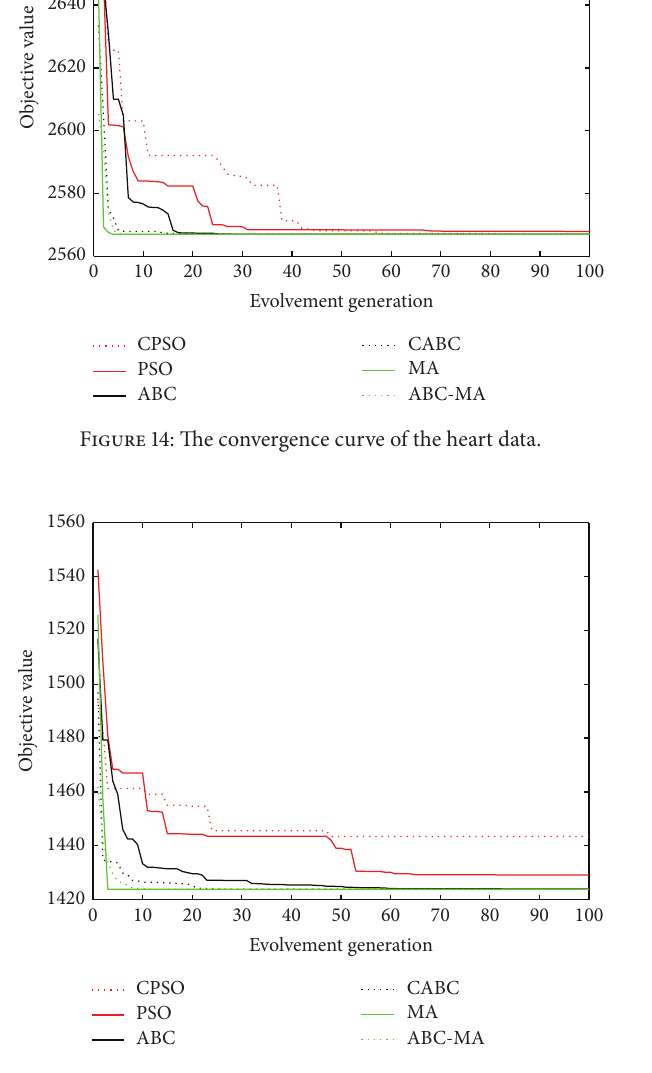
Figure 17: The convergence curve of the cancer data.